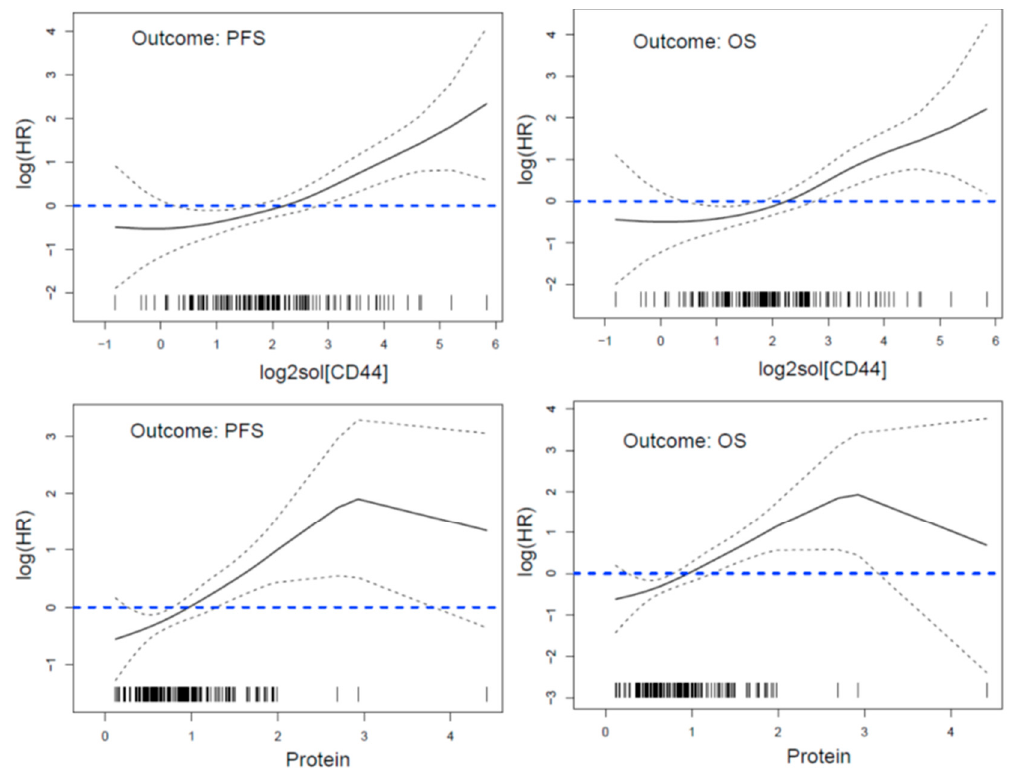
Figure 2. Estimated log hazard ratios (HRs) obtained from Cox regressions with restricted cubic splines functions of log2[solCD44] or protein to allow a non-linear relationship between the continuous variable and the log HR of progression or death.